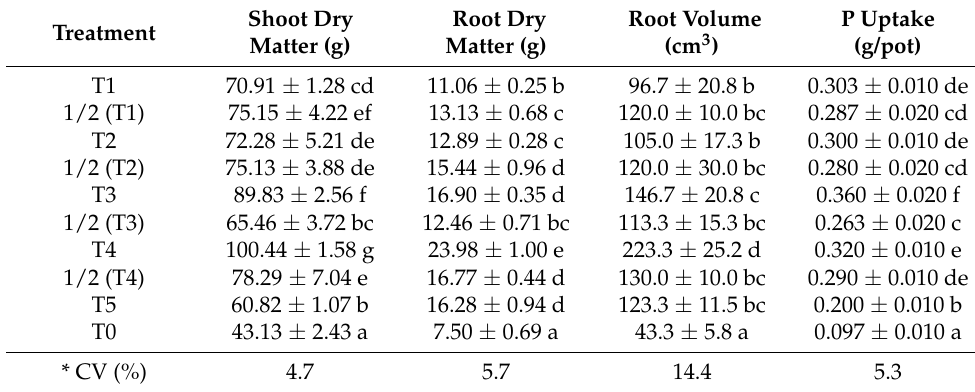
Table 4. Effects of amendments on agronomic